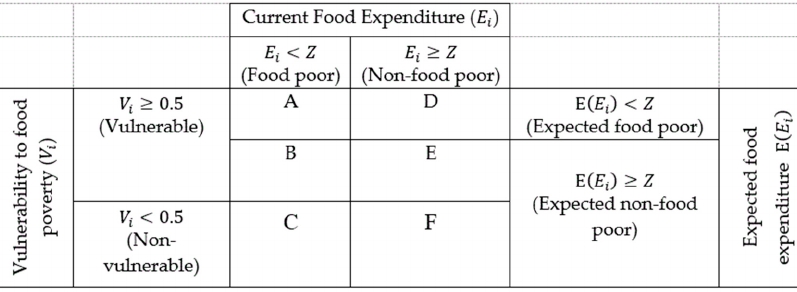
Figure 2 . Distribution of food poverty lines.